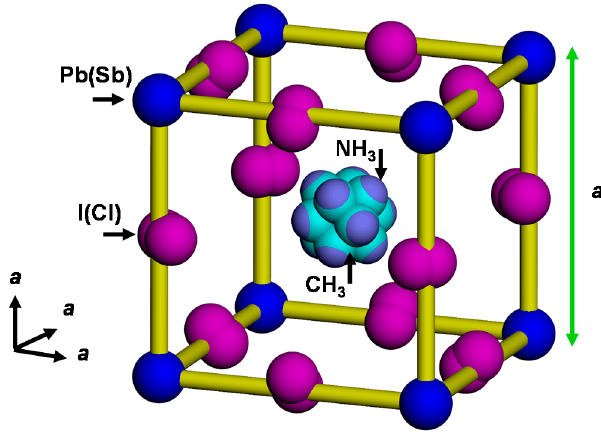
Figure 5. Structure model of cubic CH 3 NH 3 Pb(Sb)I 3 (Cl).